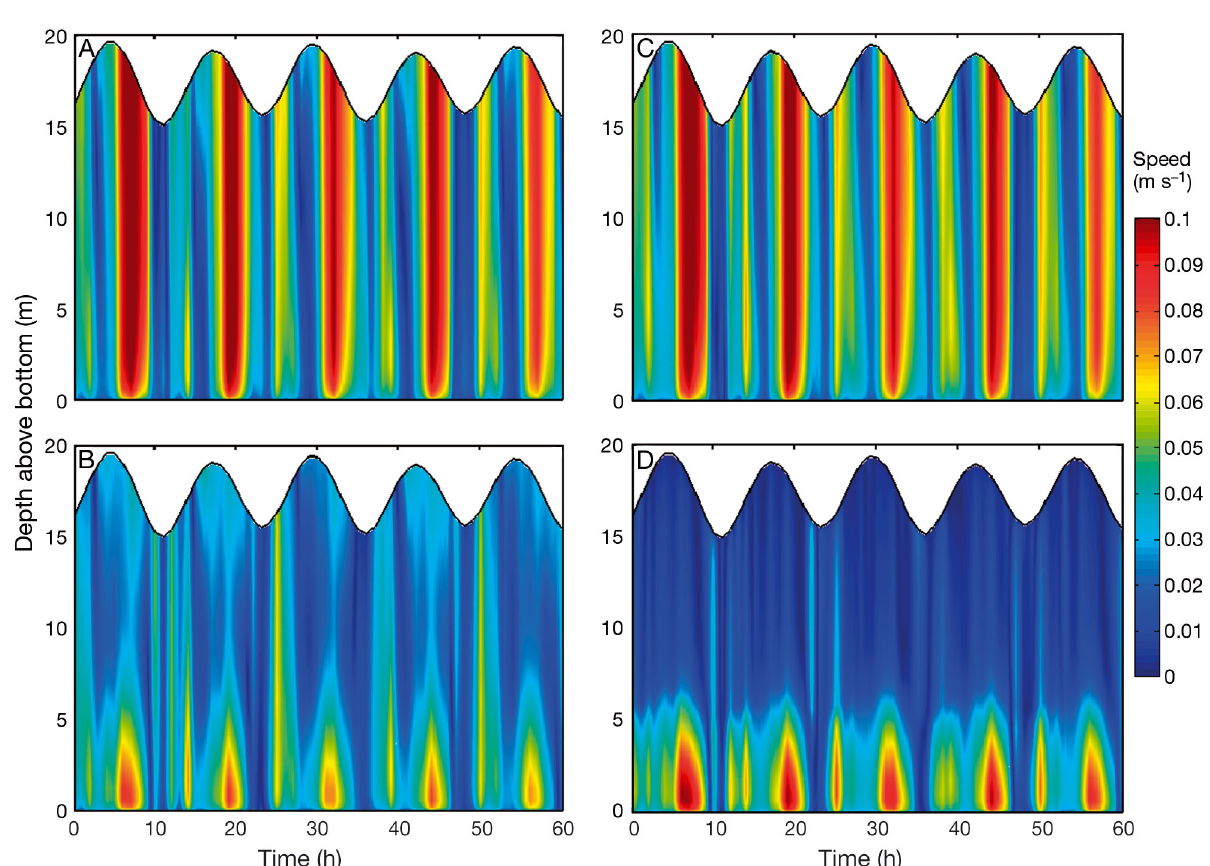
Fig. 5. Vertical distributions of tidal speeds from models (A) without and (B) with cage effect at the edge of the fish farm (see Site 6 in Fig. 1C), and (C) without and (D) with cage effect in the interior of the fish farm (see Site 8 in Fig.